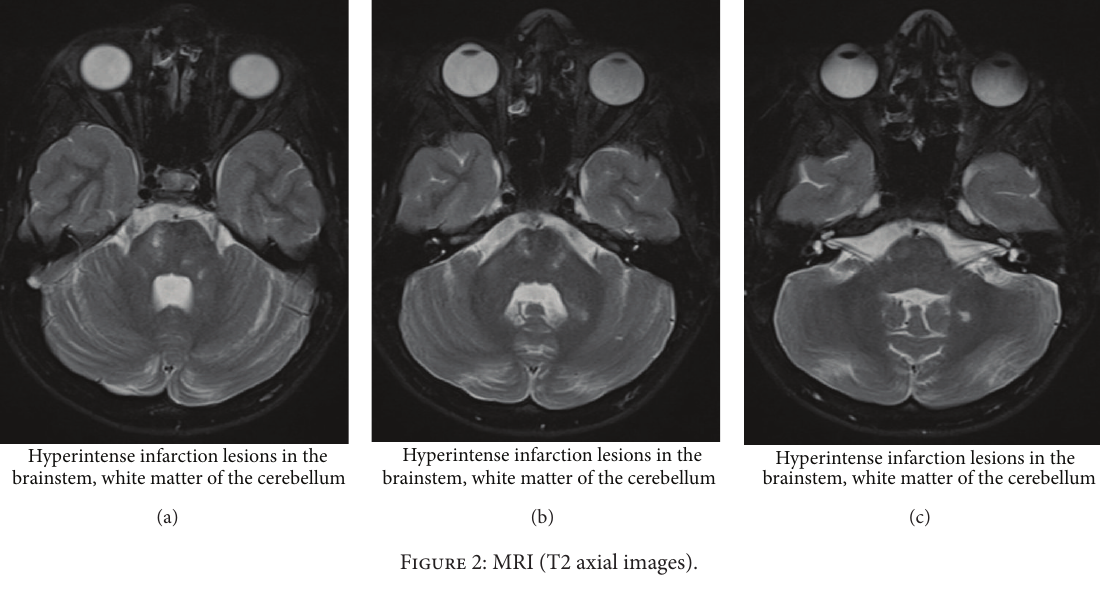
Figure 2: MRI (T2 axial